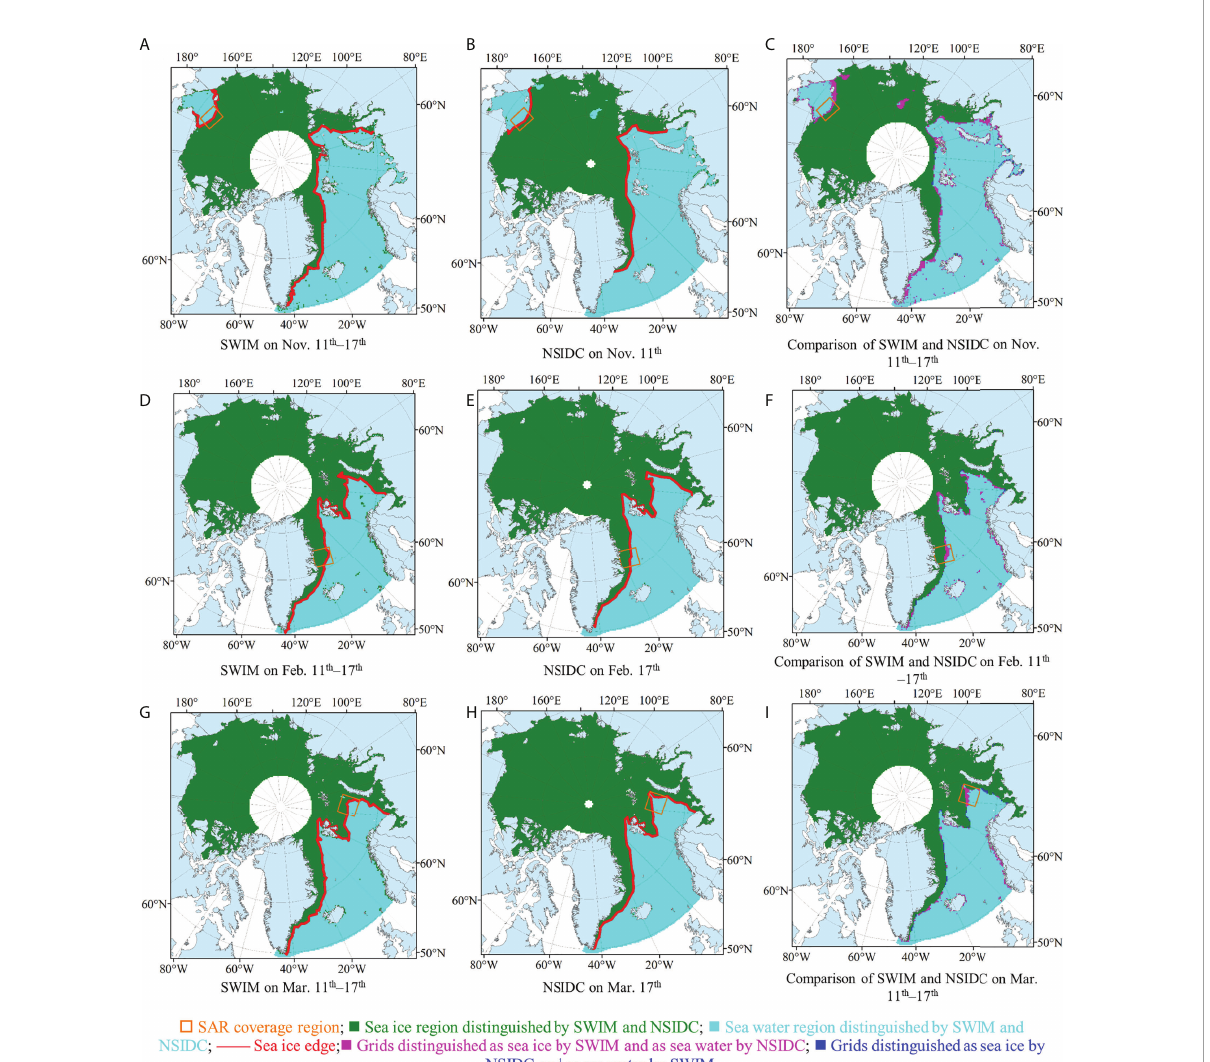
FIGURE 8 Comparison of sea ice extents and edges between SWIM and NSIDC. (A) SWIM on Nov. 11 th – 17 th ; (B) NSIDC on Nov. 11 th ; (C) Comparison of SWIM and NSIDC on Nov. 11 th – 17 th ; (D) SWIM on Feb. 11 th – 17 th ; (E) NSIDC on Feb. 17 th ; (F) Comparison of SWIM and NSIDC on Feb. 11 th – 17 th ; (G) SWIM on Mar. 11 th – 17 th ; (H) NSIDC on Mar. 17 th ; (I) Comparison of SWIM and NSIDC on Mar. 11 th – 17 th